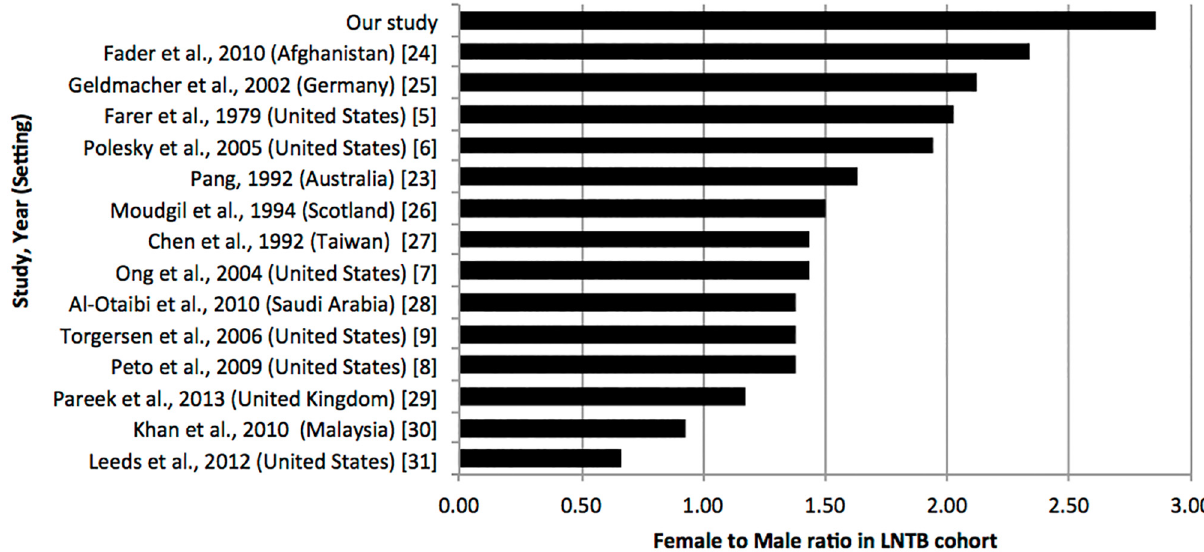
Fig 1. Ratio of females to males in LNTB cohorts of published